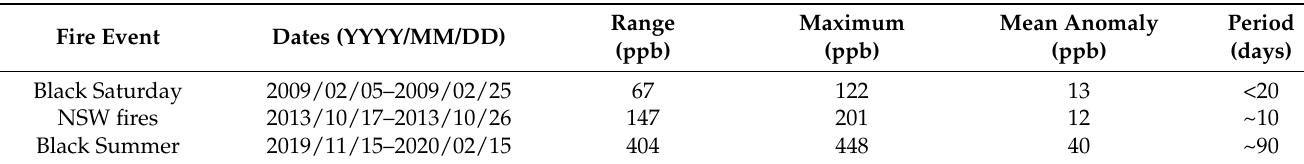
Table 1. Comparison of X CO metrics for 2019–20 fires with the past Australian fire events based on the FTS data record (hourly